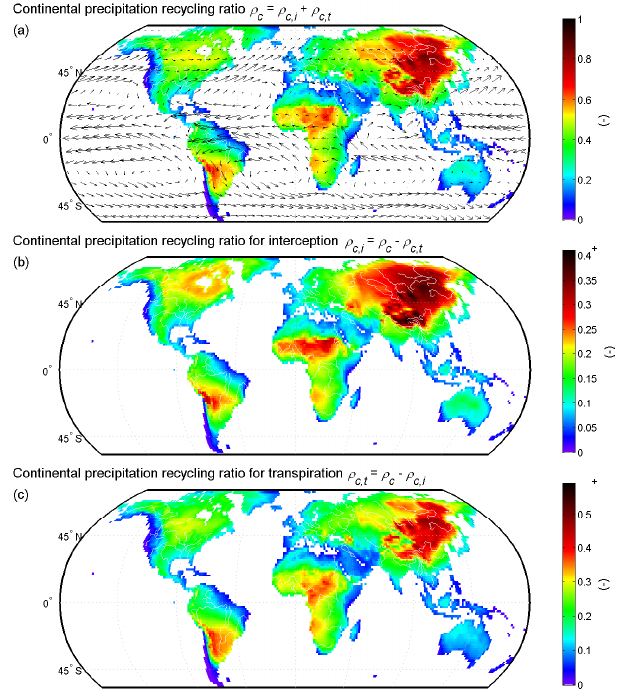
Figure 2. Continental precipitation recycling (1999–2008). (a) Continental precipitation recycling ratio ρ c , (b) continental precip- itation recycling ratio for interception ρ c,i , and (c) continental pre- cipitation recycling ratio for transpiration ρ c,t . The colour scale of (b) ends at 0.41, which is the global average fraction of direct evap- orative fluxes (interception); the colour scale of (c) ends at 0.59, which is the global average fraction of delayed evaporative flux (transpiration). The arrows in (a) indicate the vertically integrated moisture